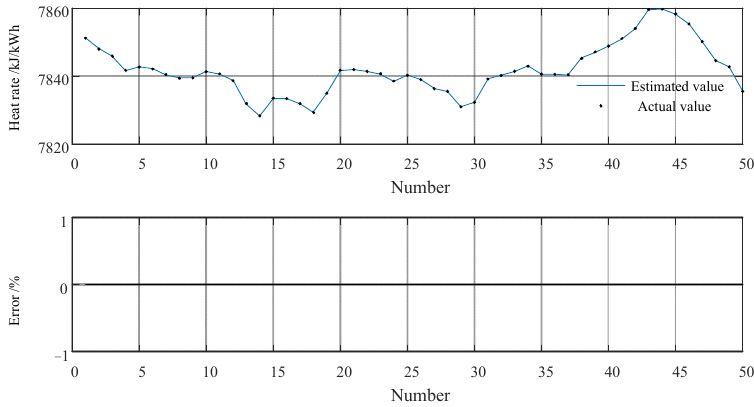
Figure 6. The model training results of the heat rate index.